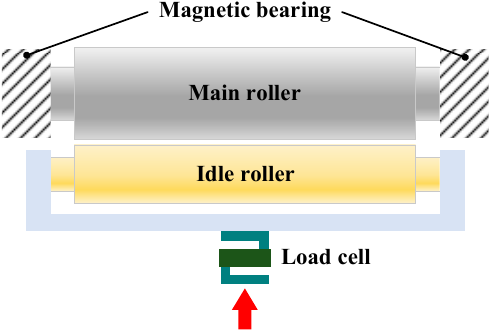
Figure 6. Conceptual diagram of roll-to-roll load condition test.